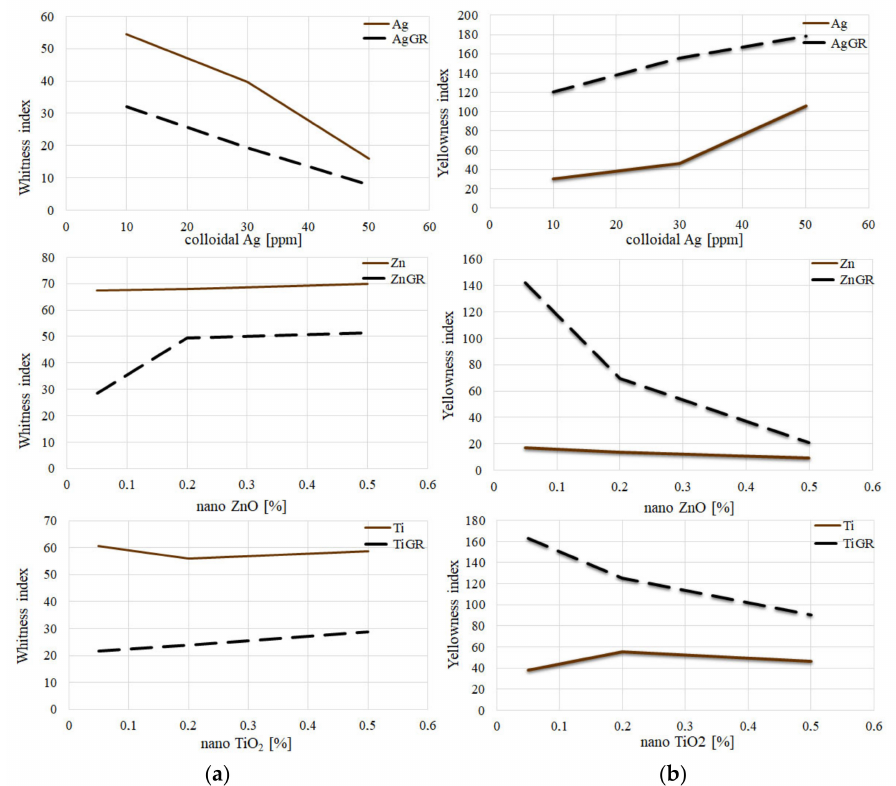
Figure 7. Evaluation of color properties of packaging: ( a ) Comparison of Whiteness Index with individual additions. ( b ) Comparison of Yellowness Index with individual